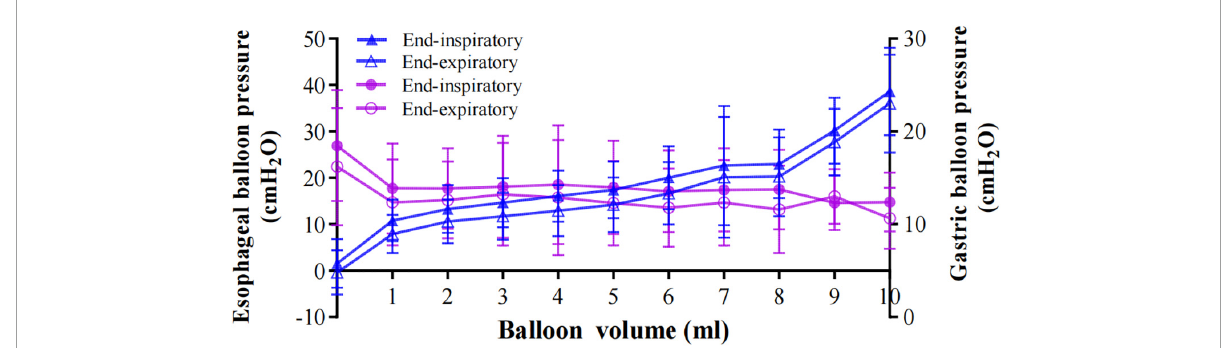
FIGURE7 The relationship between gastric pressure and esophageal pressure. Solid blue triangles represent Pes EI and hollow blue triangles represent PesEE . Gastric balloon pressure of end-inspiration (Pga EI ) and end-expiration (Pga EE ) are represented by solid purple circles and hollow purple circles, respectively. As the esophageal balloon volume increased, the gastric pressure remained relatively stable. Data are shown as the mean value ± standard deviation.